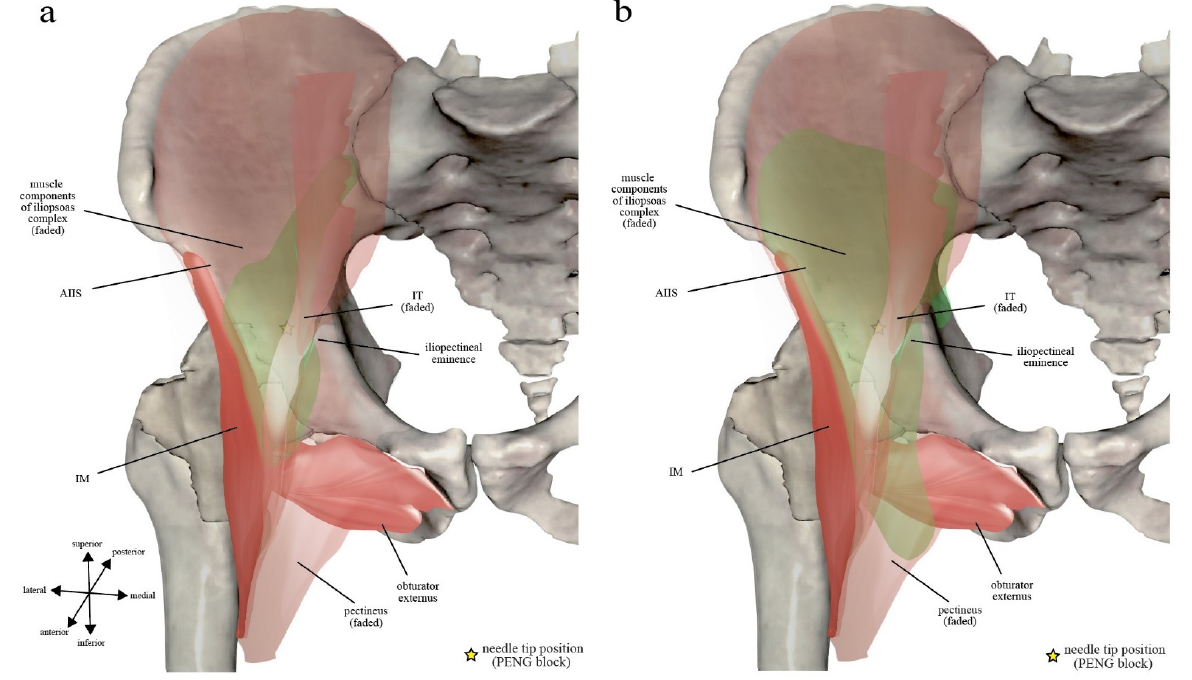
Figure 5. Injectate spread in a cadaver after pericapsular nerve group (PENG) block: (a) Injectate spread after 10 mL PENG block is colored in faded green and is overlayed with the faded iliopsoas complex to demonstrate its spatial relationship to the iliacus minor (IM) and iliopsoas tendon (IT). Note the presence of injectate spread deep and medial to IT; (b) Injectate spread after 20 mL PENG block is again colored in faded green and overlayed with the iliopsoas complex. In comparison to 10 mL PENG block, the more extensive spread of a 20 mL PENG block includes an inferomedial extension into the subpectineal plane (SP), from where divisions of the obturator nerve emerge, and a superomedial extension into the lesser pelvis, where the obturator nerve proper traverses intrapelvically towards the obturator canal. The final needle tip position of PENG block is marked as a yellow star deep to IT. The illustrated Figure was made from an image acquired from the VH Dissector with permission from Touch of Life Technologies Inc (www.toltech.net), based on the results of a cadaveric dye injection study by Tran et al. [22]. The original image was reconstructed from real cadaver by the Visible Human Project®of National Library of